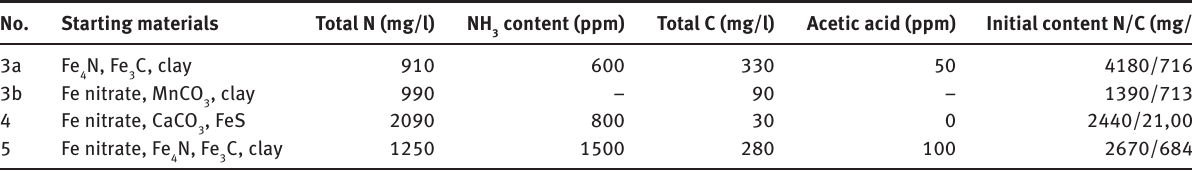
Table 3: Analytical results of the TOC, IC, and GCMS